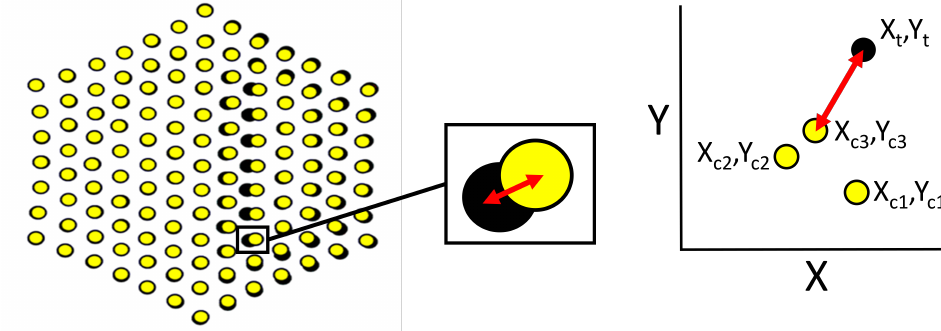
Figure 4: (Left) Schematic of how difference in pin location between taps is used to detect anomalies. Here the Black dots show the TacTip response to a correct flat surface while the yellow dots show the response to an anomalous contoured surface. (Right) Schematic Diagram of the ‘Nearest Neighbour’ Technique, in this case the test tap (Black) was closest to the third of the training